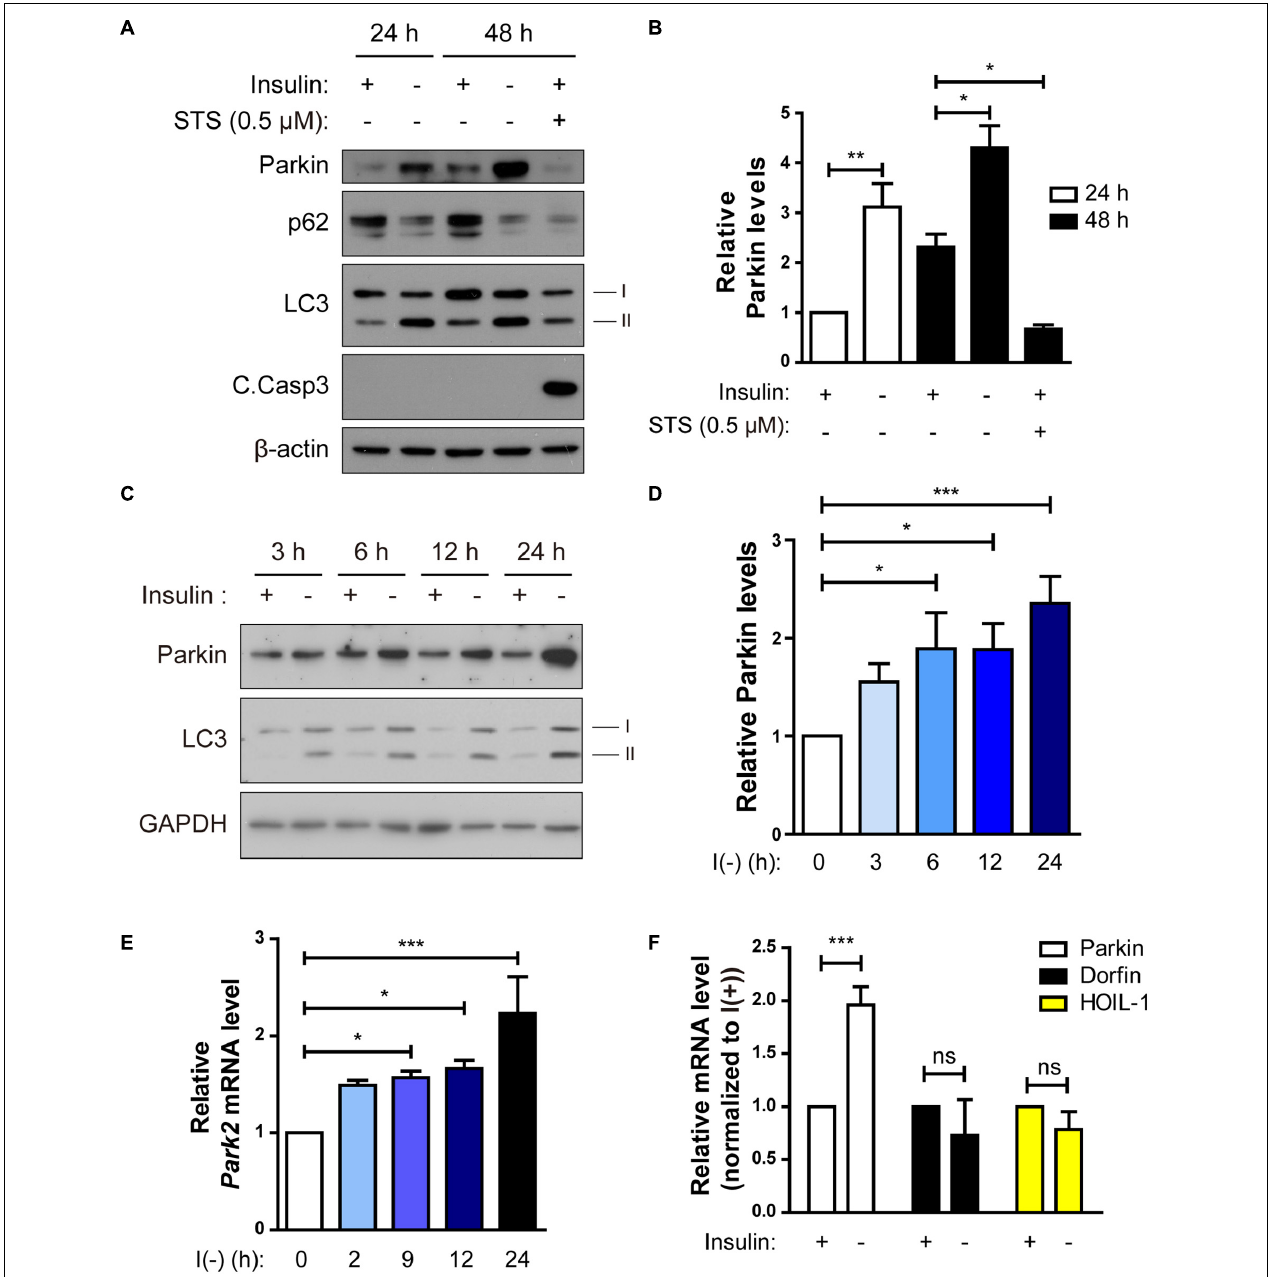
FIGURE 4 | Parkin expression is upregulated following insulin withdrawal. (A) Western blotting analysis of Parkin protein level in HCN cells after insulin withdrawal for 24 and 48 h. (B) Quantification of Parkin protein level ( n = 3 or 4). (C) Time course analysis of Parkin protein levels following insulin withdrawal. (D) Quantification of Parkin protein levels ( n = 5) from (C) . (E) Time course analysis of mRNA levels of Parkin following insulin withdrawal ( n = 4). (F) Changes in the mRNA levels of Parkin, Dorfin, and HOIL-1 ( n = 3–7). ∗ p < 0.05, ∗∗ p < 0.01, ∗∗∗ p < 0.001; ns, not